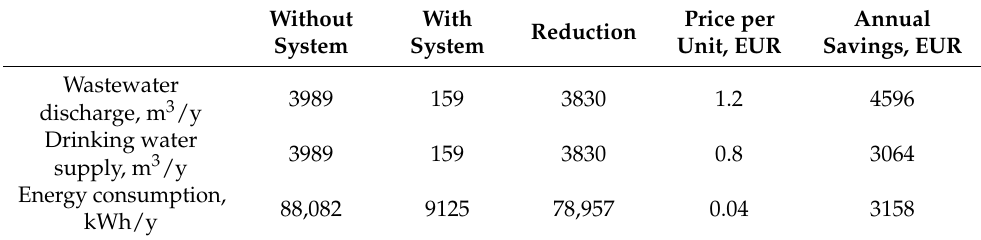
Table 1. Cost reduction after using the system with filter tubes.